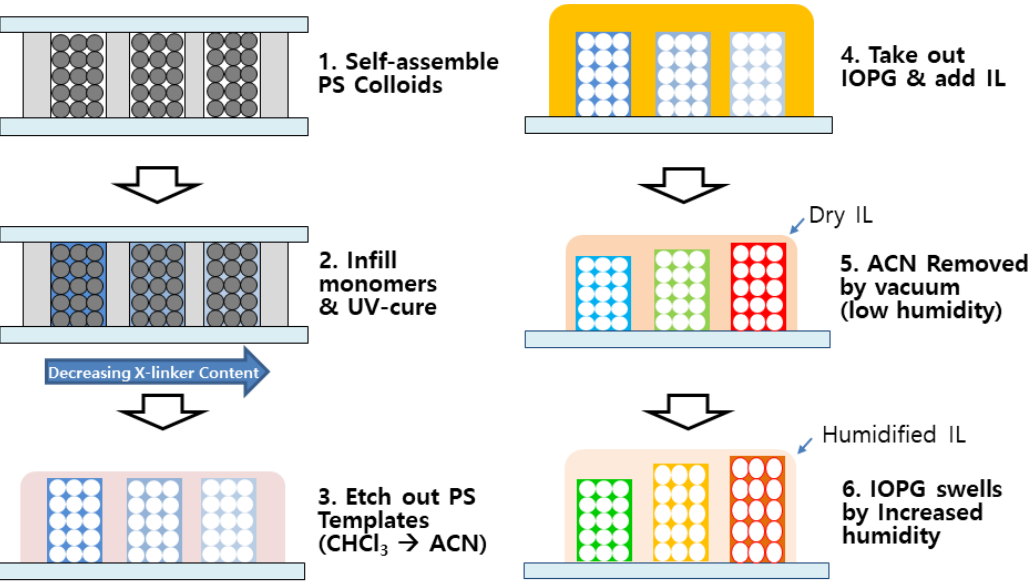
Figure 1. Schematic illustration showing fabrication procedures of PHEMA IOPG, and its swelling behavior under humidified condition.